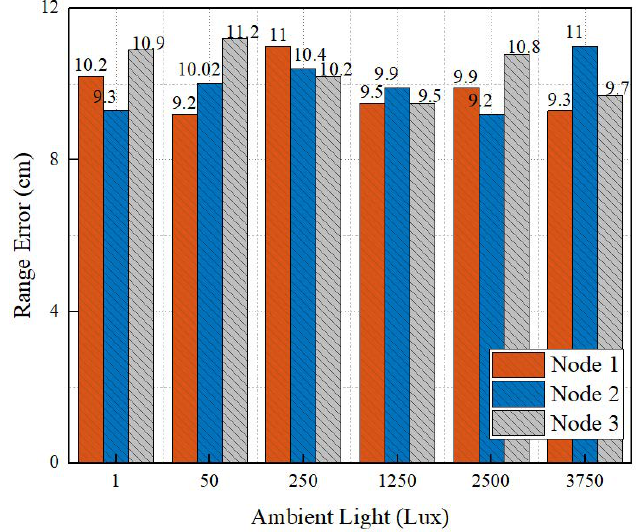
Figure 18. Impact of ambient light on ranging